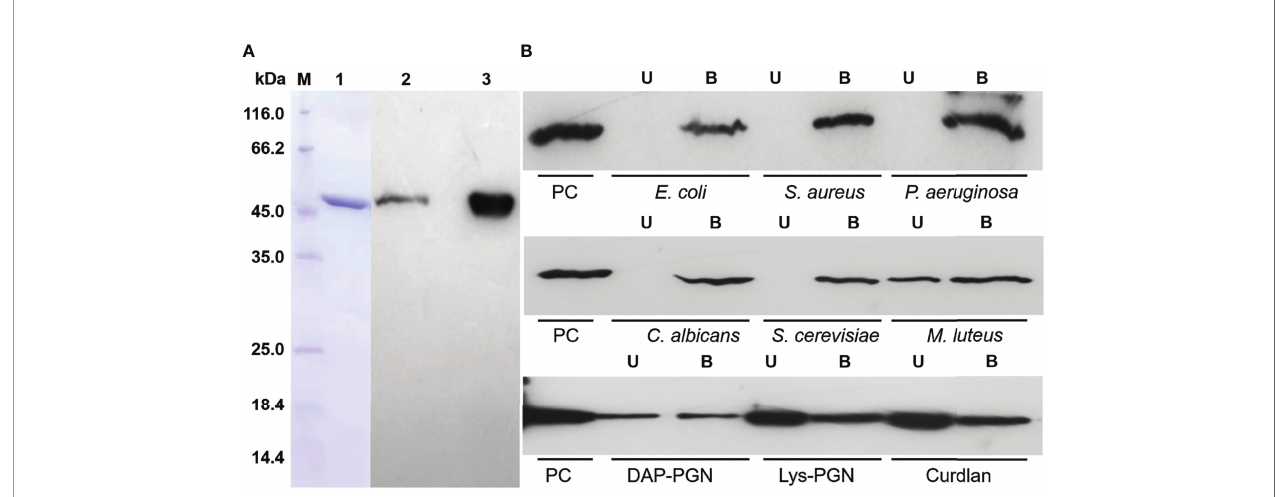
FIGURE 1 | Identi fi cation of His 6 - Ap -hemolin and its binding to insoluble pathogens. (A) SDS – PAGE and immunoblot analysis of Ap -hemolin. Lane 1: puri fi ed recombinant His 6 - Ap -hemolin (5 m g, Coomassie Brilliant Blue staining); Lane 2: natural hemolin in A. pernyi hemolymph (5 mg/ml); Lane 3: His 6 - Ap -hemolin (40 m g/ ml); both Lanes 2 and 3 (30 m l volume per lane) were detected by western blotting assay using the anti- Ap -hemolin antibody. (B) Binding of His 6 - Ap -hemolin to microorganisms and insoluble PAMPs was detected by western blotting. A total of 10 m g of His 6 - Ap -hemolin was incubated with microbial cells or insoluble PAMPs. Supernatant and washing fractions were combined as the unbound sample (U). The bound sample (B) was eluted with 1 × SDS sample buffer. His 6 - Ap -hemolin was used as a positive control (PC). Three biological replicates were